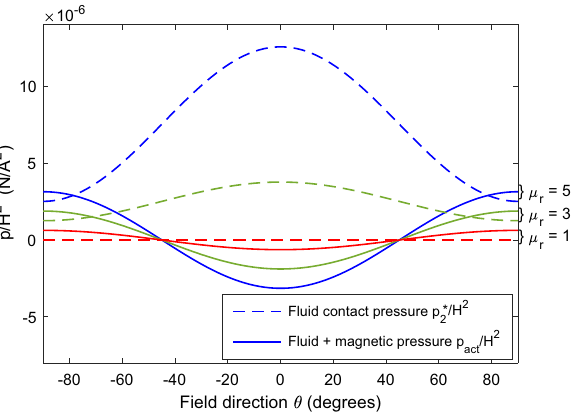
Figure 3. Dependency of interface pressures on magnetic field direction (angle of incidence) for ferrofluids with different linear magnetization properties.